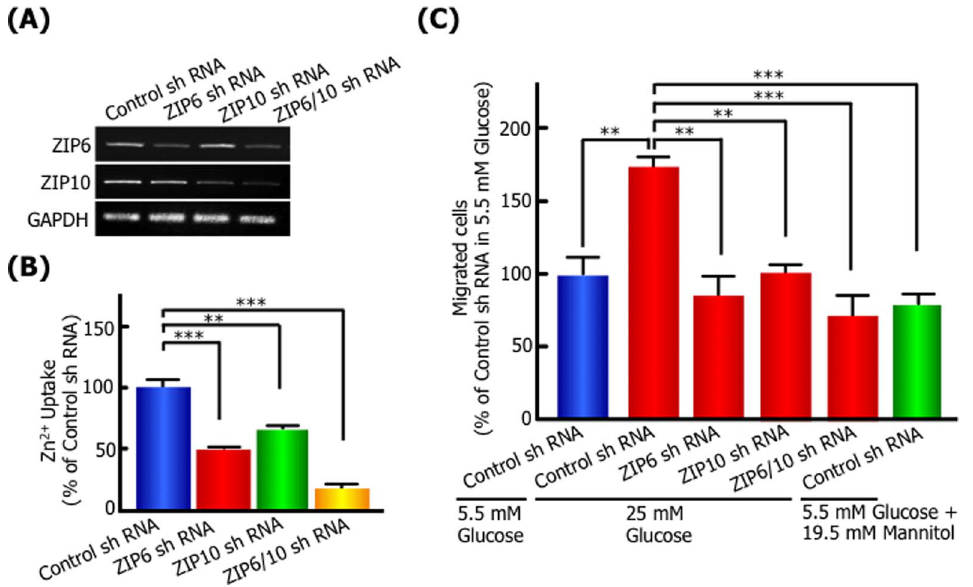
Figure 5. ZIP and intracellular zinc are essential for high glucose-induced migration. MCF-7 cells were transfected with shRNA each for ZIP6, ZIP10, and control sequences. The knockdown effect of ZIP6 shRNA and/or ZIP10 shRNA was shown in RT-PCR (A) and Zn 2 + uptake activity in MCF-7 (B) . (C) In transwell migration assays, MCF-7 cells transfected each with shRNA for ZIP6 and ZIP10 were incubated with high (25 mM) D- glucose concentration for 24 h, and migrated cells were analyzed as described in Materials and Methods. Data are presented as means 6 SD. ** p , 0.01, *** p , 0.001, n=3.